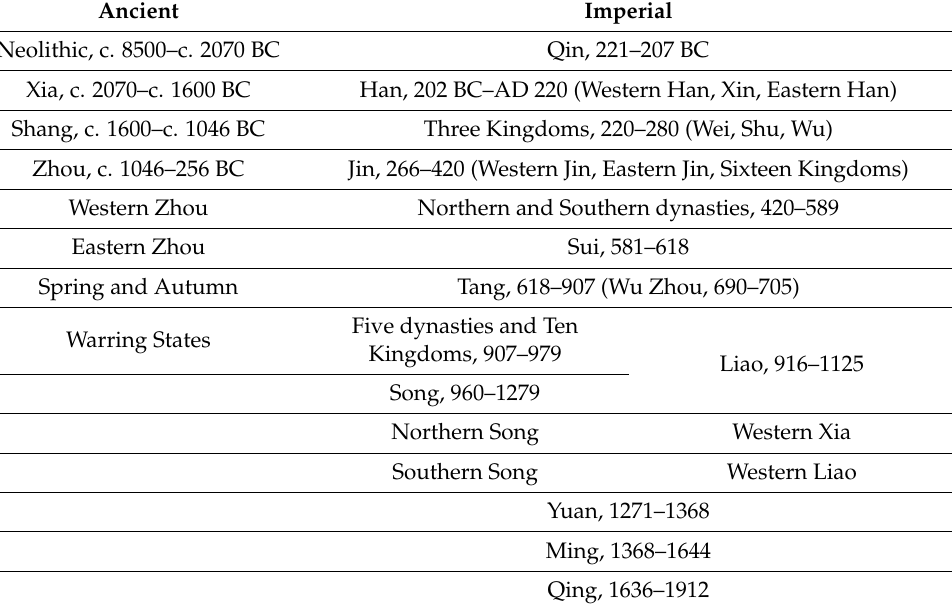
Table 1. Chinese